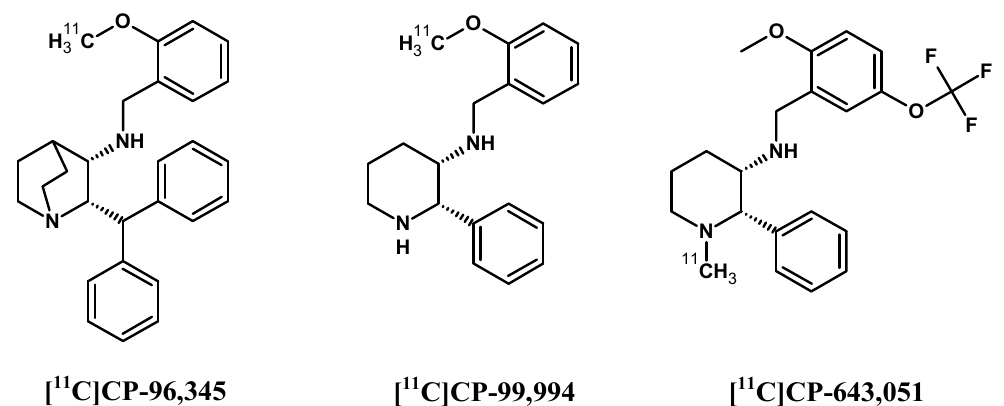
Figure 4. Structures of the first radioligands of neurokinin 1 receptor.